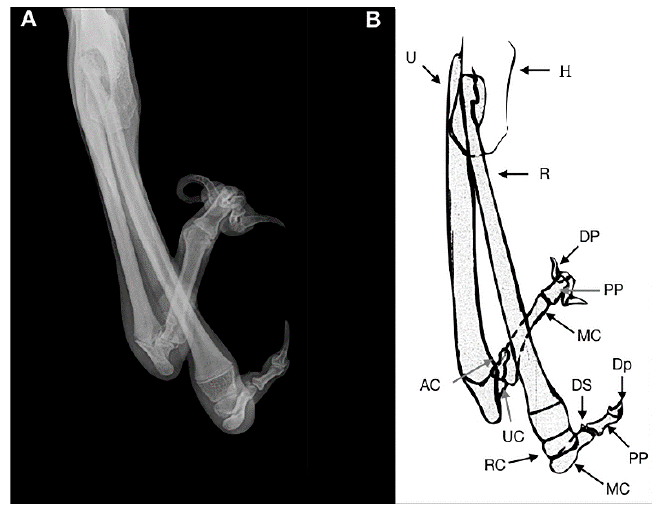
Figure 5. Case 2. Craniocaudal radiograph ( A ) and drawing scheme ( B ) of the right forelimb malformation. R: Radius; U: Ulna; H: Humerus; RC: Radial Carpal Bone; UC: Ulnar Carpal Bone; AC: Accessory Bone; MC: Metacarpal Bone; PP: Proximal Phalange; DP: Distal Phalange; DS: Dorsal Sesamoid. Note the “stubby bone” (arrows) resulting by the fusion of the two proximal phalanges.